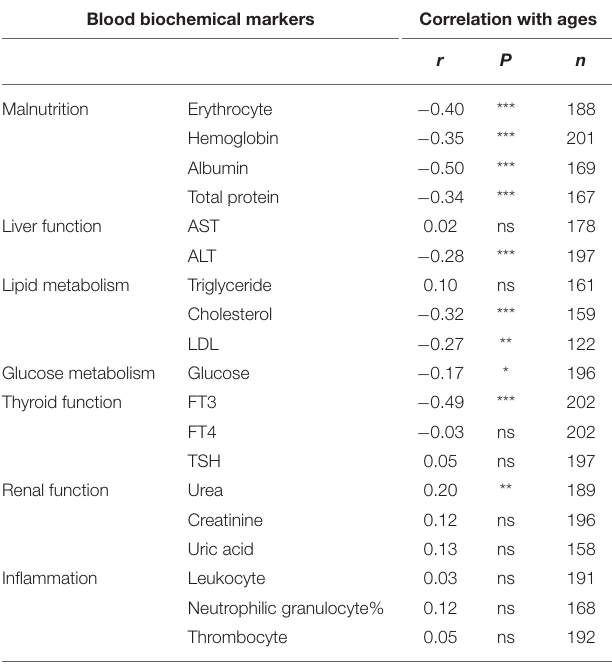
TABLE 4 | Peripheral organs functions and nutrition homeostasis correlated with age. Blood biochemical markers Correlation with